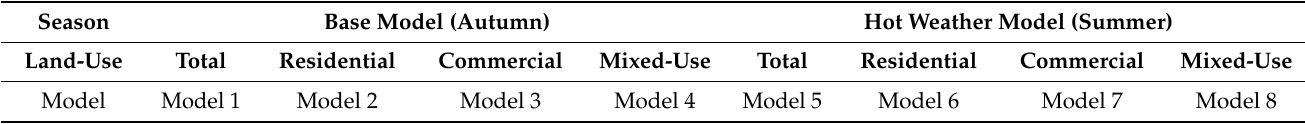
Table 3. Classification of